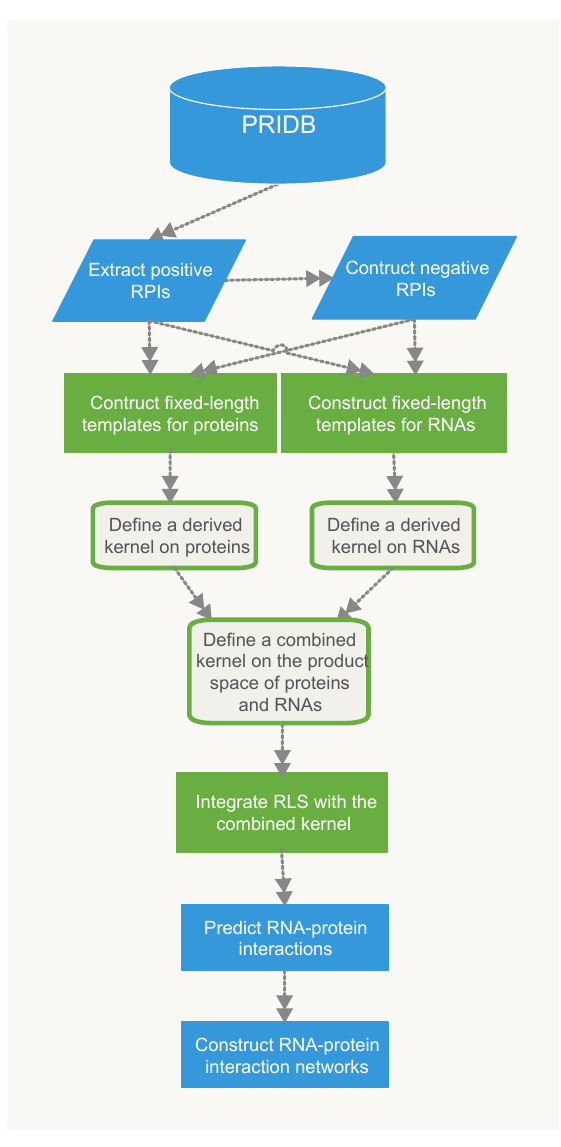
Figure 6. The work flow for the proposed RPiRLS